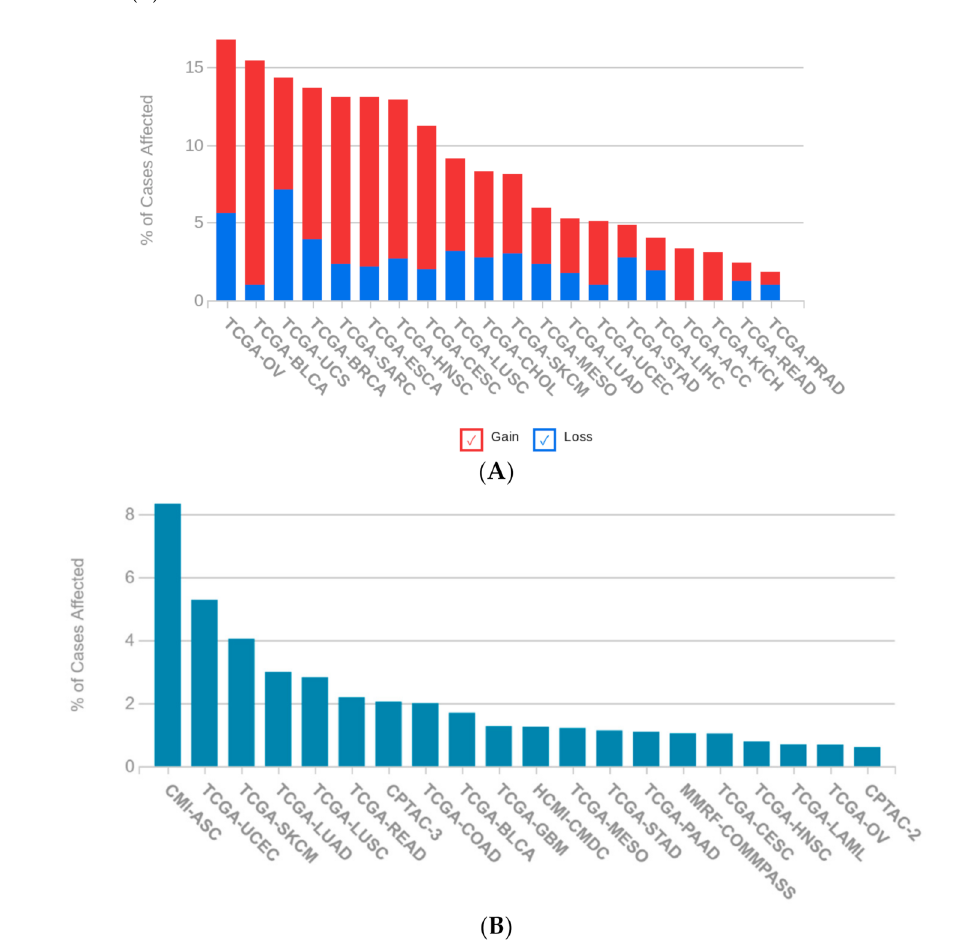
Figure A6. CNV and mutation distribution of CD20 (MS4A1) in different cancer types. ( A ) CNV distribution. ( B ) Mutation